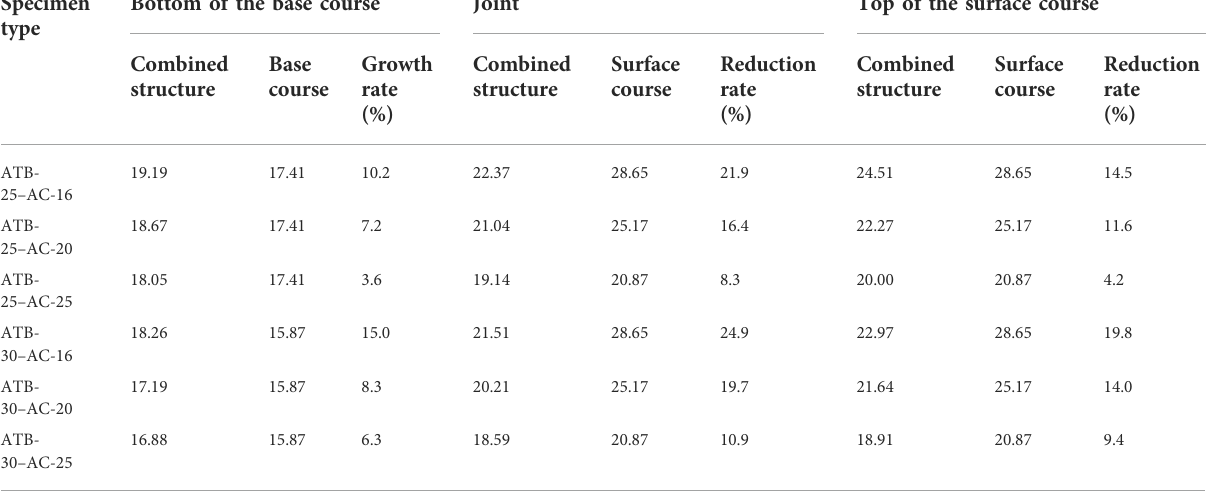
Bottom of the base